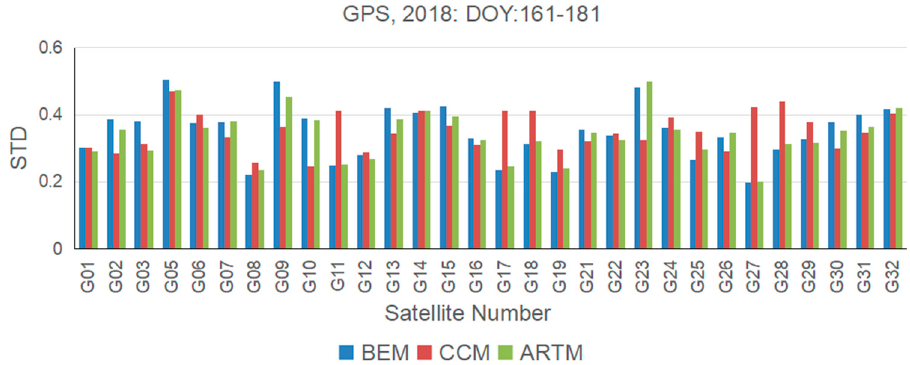
Figure 3. The STD of the satellite repeat shift time for the three methods for each satellite during the period DOY:161–181, 2018.